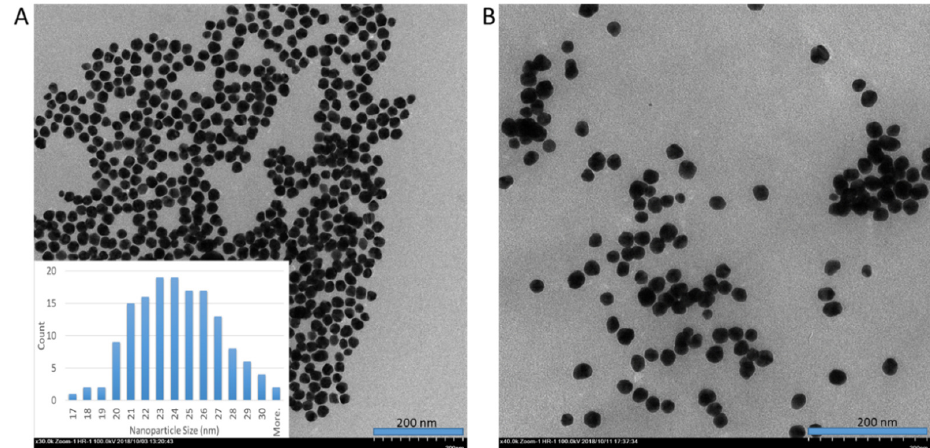
Figure 10. TEM micrographs of gold nanoparticles in toluene with octadecylsilane as the phase- transfer molecule. (( A ) 30 k zoom. ( B ) 60 k zoom).